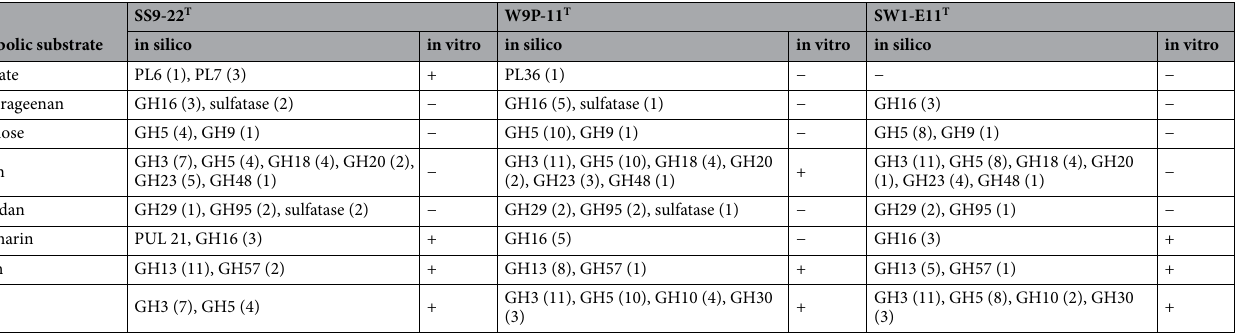
Table 7. Polysaccharide-degrading genes and in vitro activities of strains SS9-22 T , W9P-11 T , and SW1-E11 T